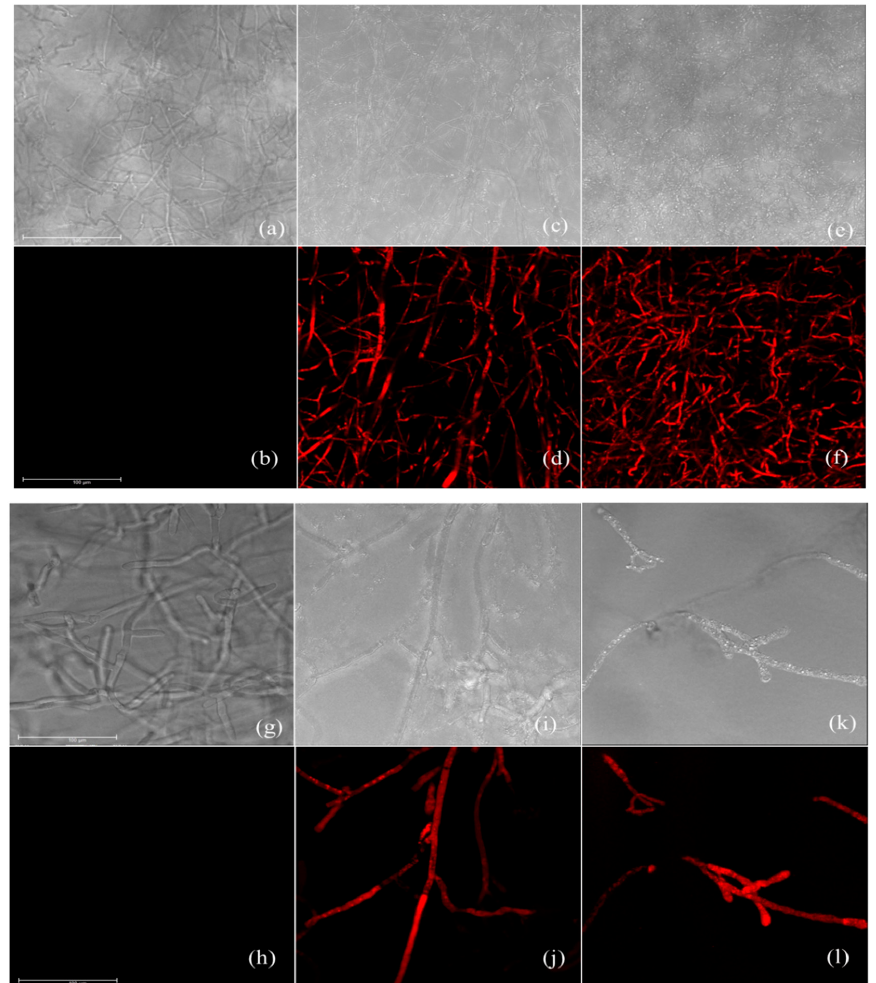
Figure 2. Confocal laser scanning microscopy images of ROS generation. Bright mode ( a ) and confocal image ( b ) of untreated R. quercus-mongolicae . Bright mode ( c ) and confocal image ( d ) of R. quercus- mongolicae treated with thymol. Bright mode (e) and confocal image (f) of R. quercus-mongolicae treated with carvacrol. Bright mode ( g ) and confocal image (h) of untreated R. solani . Bright mode ( i ) and confocal image ( j ) of R. solani treated thymol. Bright mode (k) and confocal image ( l ) of R. solani treated with carvacrol. Scale bar = 50 μ m.